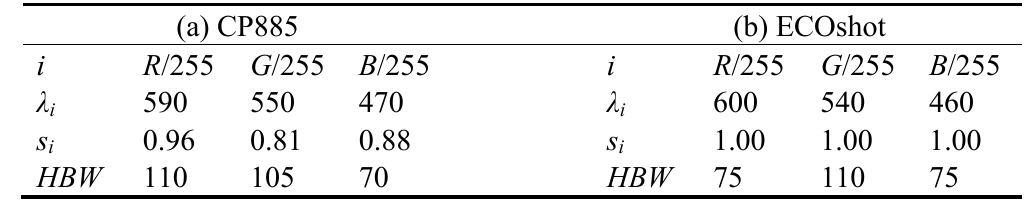
Table 2. Centre wavelength λ of band i , regarding spectral response values of RGB /255 (Figure 4), of digital camera